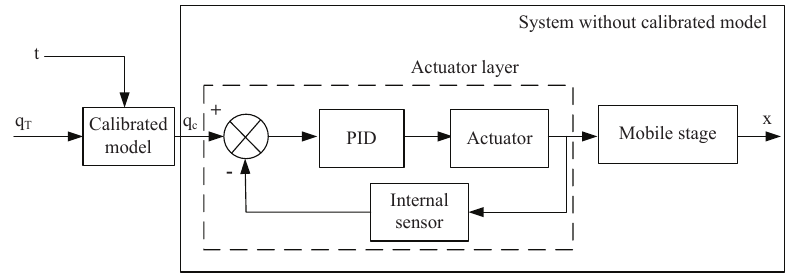
Figure 4. Block diagram of the nanopositioning stage with the static calibration